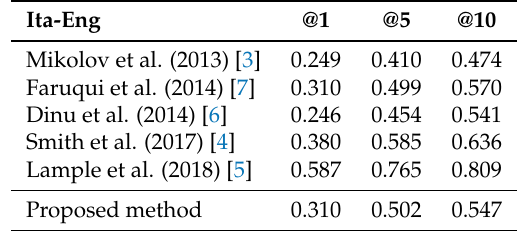
Table 15. Comparing Italian–English results on Dinu’s